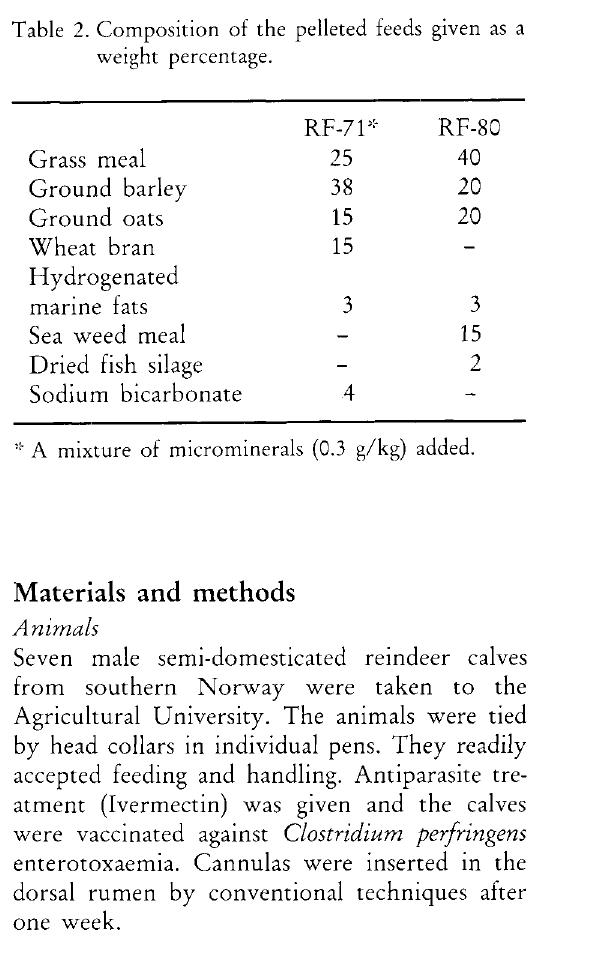
Table 1. Chemical composition of the feeds (g per 100 g of dry matter).